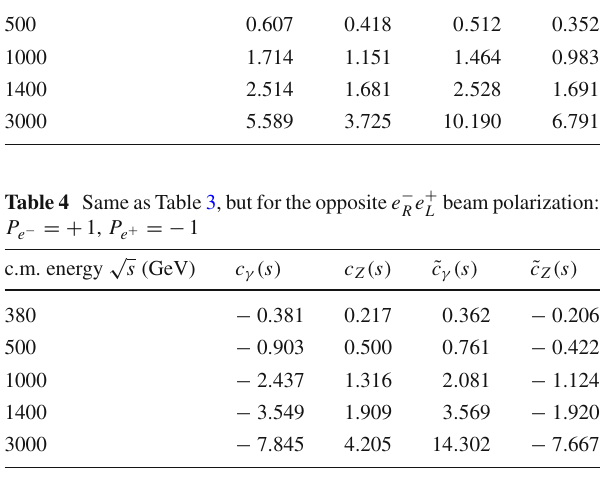
e + beam-polarizationconfiguration L R